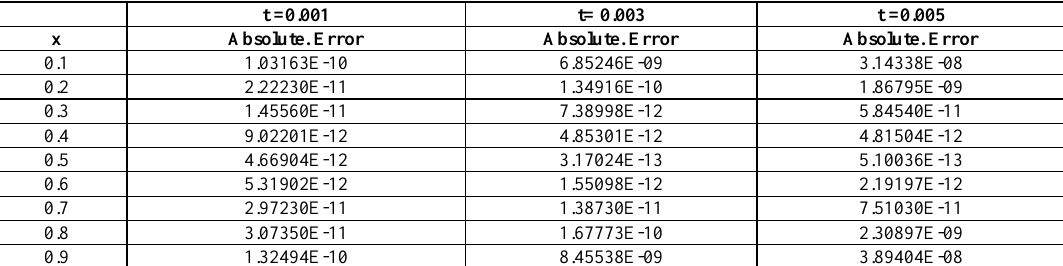
Table 3. Absolute errors obtained for Example 2 with N=21